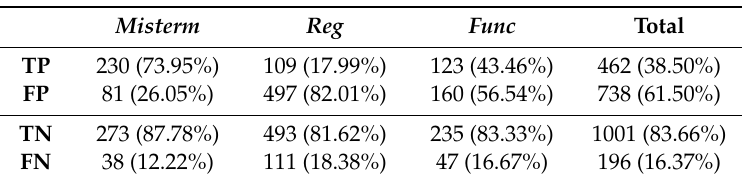
Table 8. True positives, false positives, true negatives, and false negatives of presented tokens: raw counts and